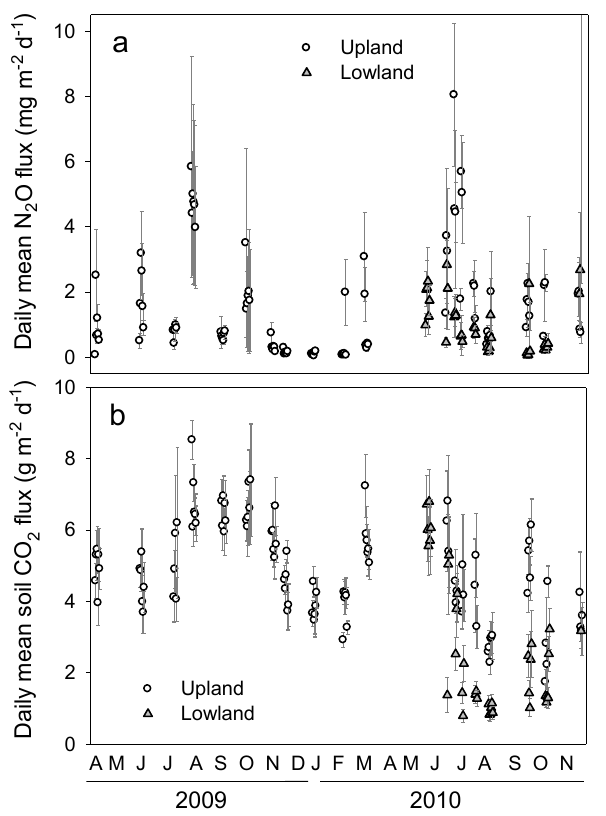
Fig. 1. Daily mean values (±one st dev) of N 2 O fluxes (a) and soil respiration (b) measured in the uphill and downhill areas in 2009 and 2010.